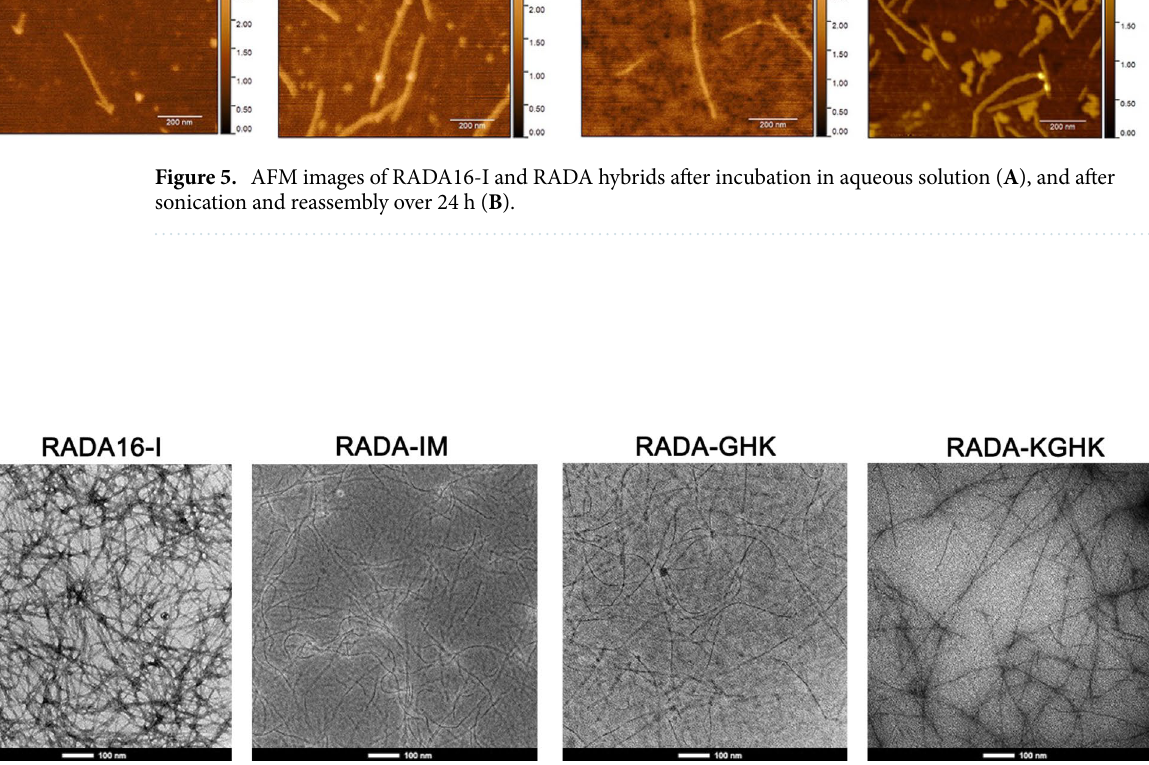
Figure 6. TEM images of RADA16-I and RADA